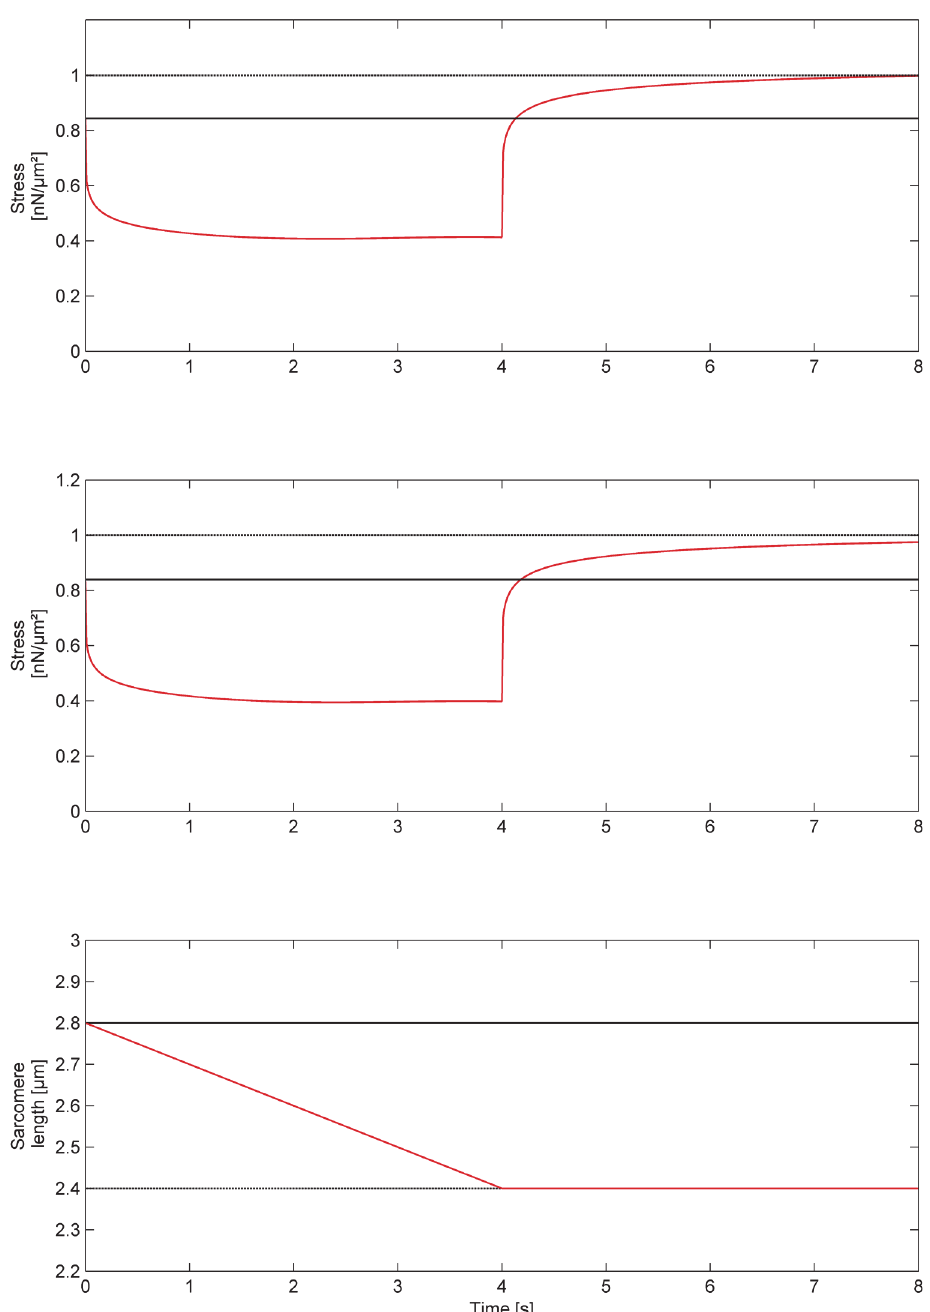
Fig 8. Simulation of an experiment where the sarcomere is passively stretched to a length of 2.6 μ m, activated and shortened to 2.4 μ m (see also Fig. 7). The resulting force is normalized to the isometric force at 2.4 μ m. Forces for the regular cross-bridge model (top panel) and the three filament model (second panel) are calculated for a shortening velocity of 100nm/s/Sarcomere length. The corresponding sarcomere length is shown in the third panel. In contrast to the regular cross-bridge model the three filament model predicts small but significant force depression in a single (half) sarcomere.